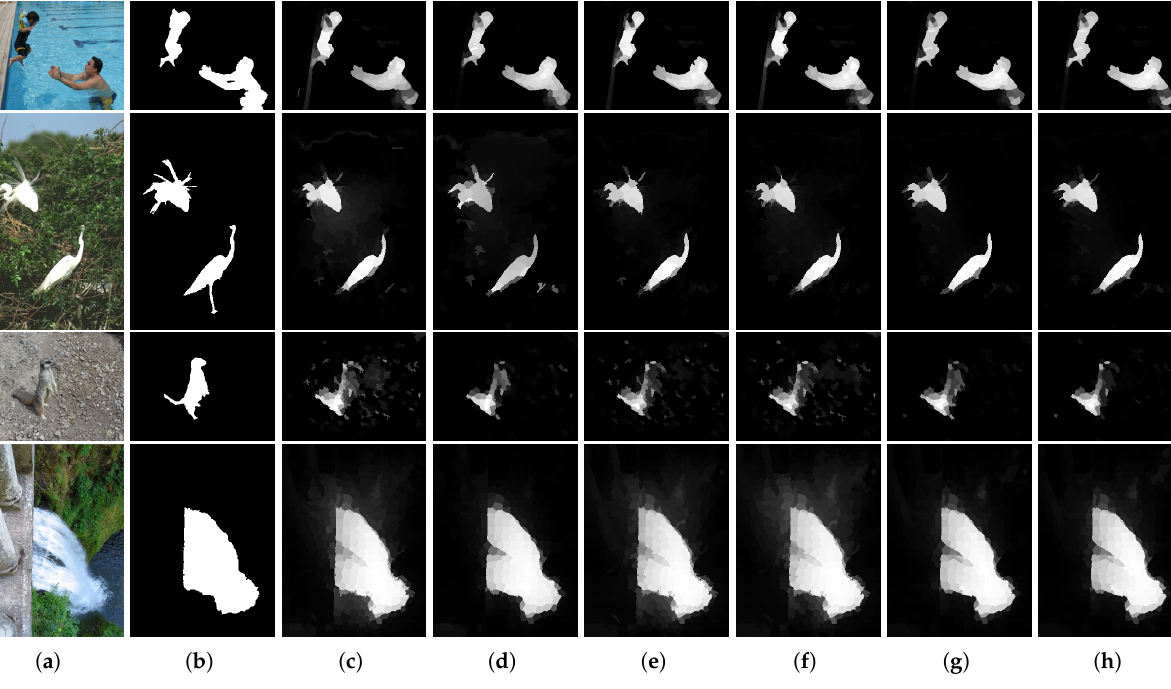
Figure 9. Visual comparison for GLGOV [50]. ( a ) Input images; ( b ) ground truth; ( c ) results of GLGOV; ( d ) BF; ( e ) ODOG; ( f ) LODOG; ( g ) BF+ODOG; ( h )